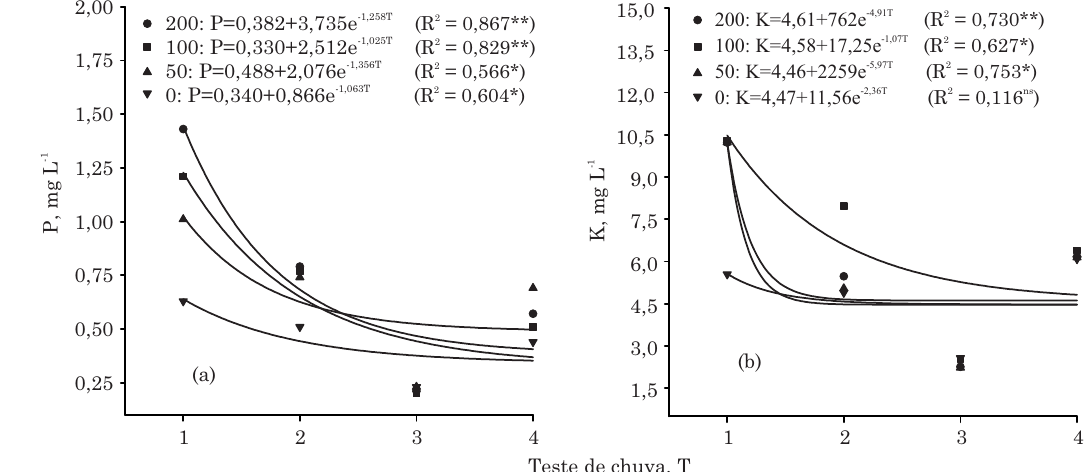
Figura 1. Relação entre os teores de fósforo (a) e potássio (b) solúvel obtidos na água da enxurrada ao final da chuva e o número de teste de chuva simulada aplicada, em cada um dos tratamentos de dose de dejeto líquido de suínos (média das